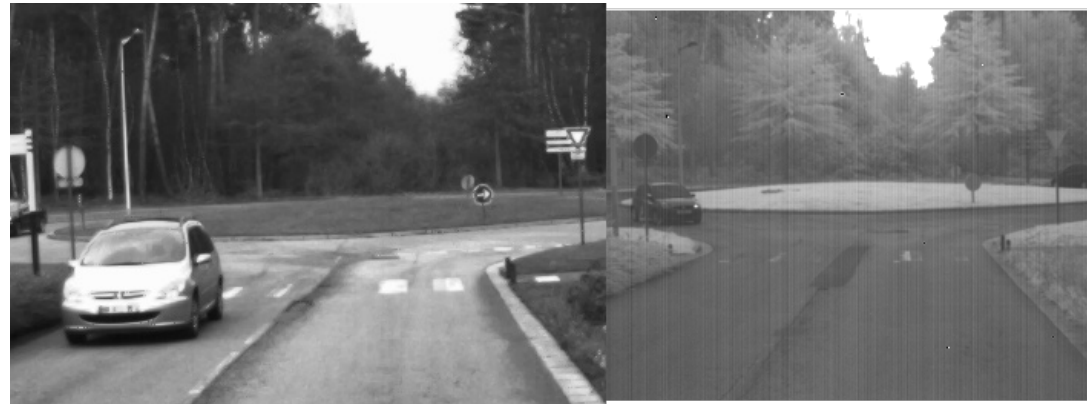
Figure 4. A infrared-visible pair from our dataset introduced in section